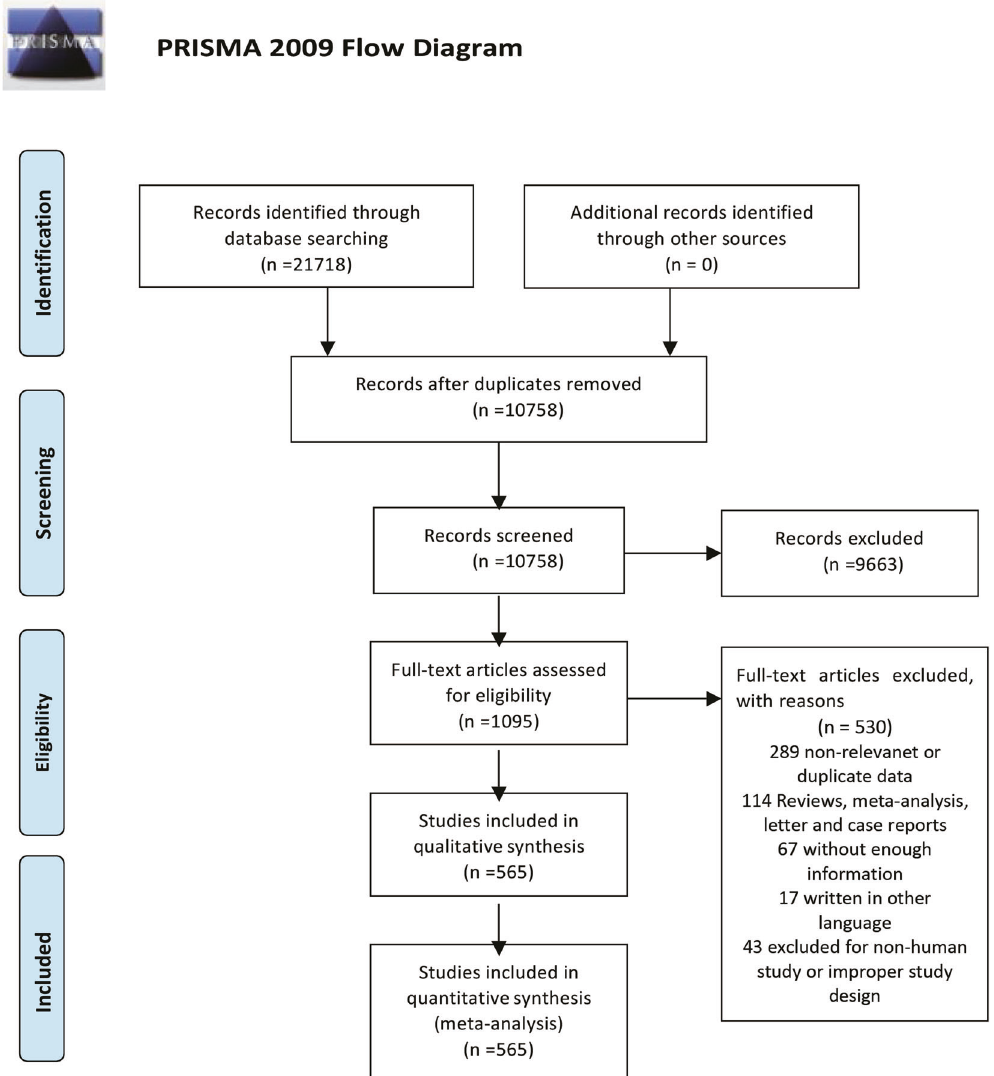
Fig. 1 Study selection. (Description of the searching